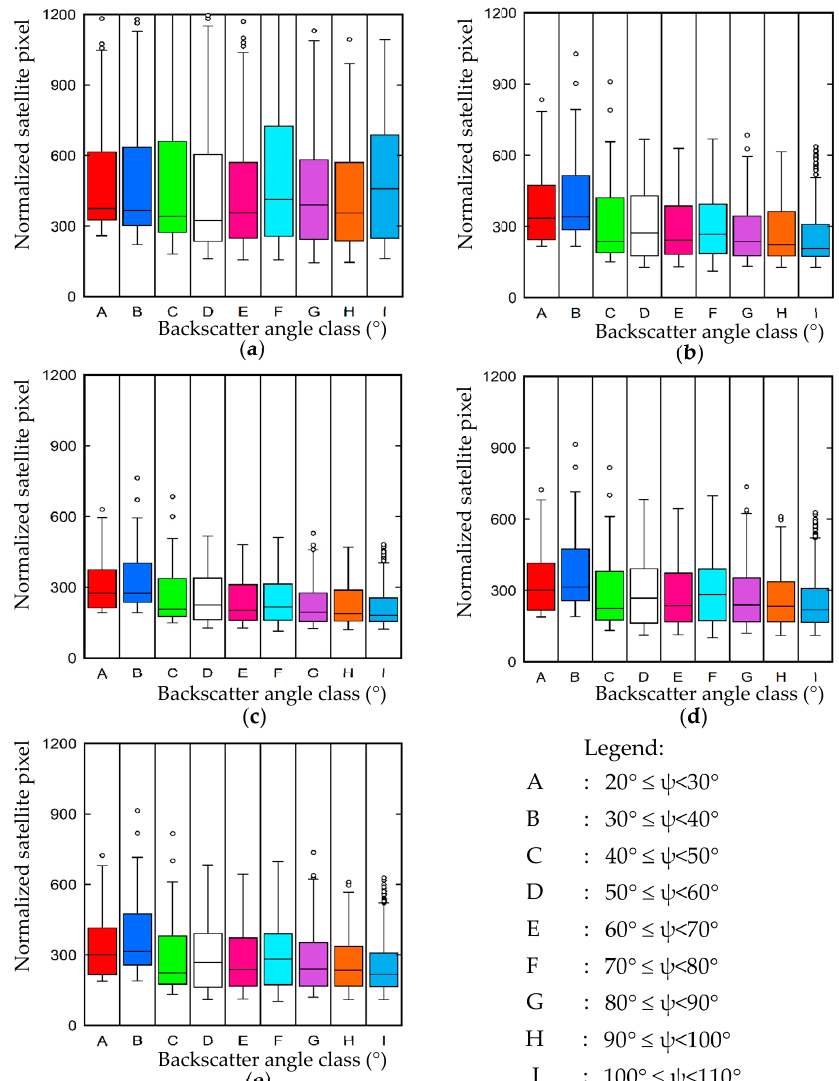
Figure 4. Normalized COMS satellite pixel against backscatter angle; ( a ) Beyer, ( b ) Rigollier, ( c ) Hammer, ( d ) Perez, and ( e ) hybrid models. The backscatter angle, ψ , was divided into nine classes with the interval of 10°. In the box-and-whisker plot, the box height is the distance between the first and the third quartiles, and the maximum and minimum is determined by the interquartile range.